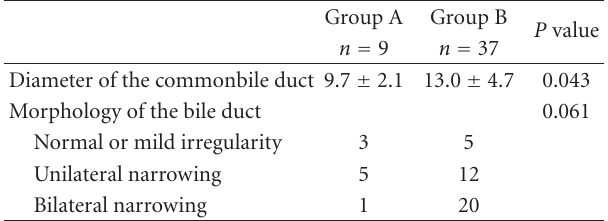
Table 4: Endoscopic retrograde cholangiopancreatography find- ings.